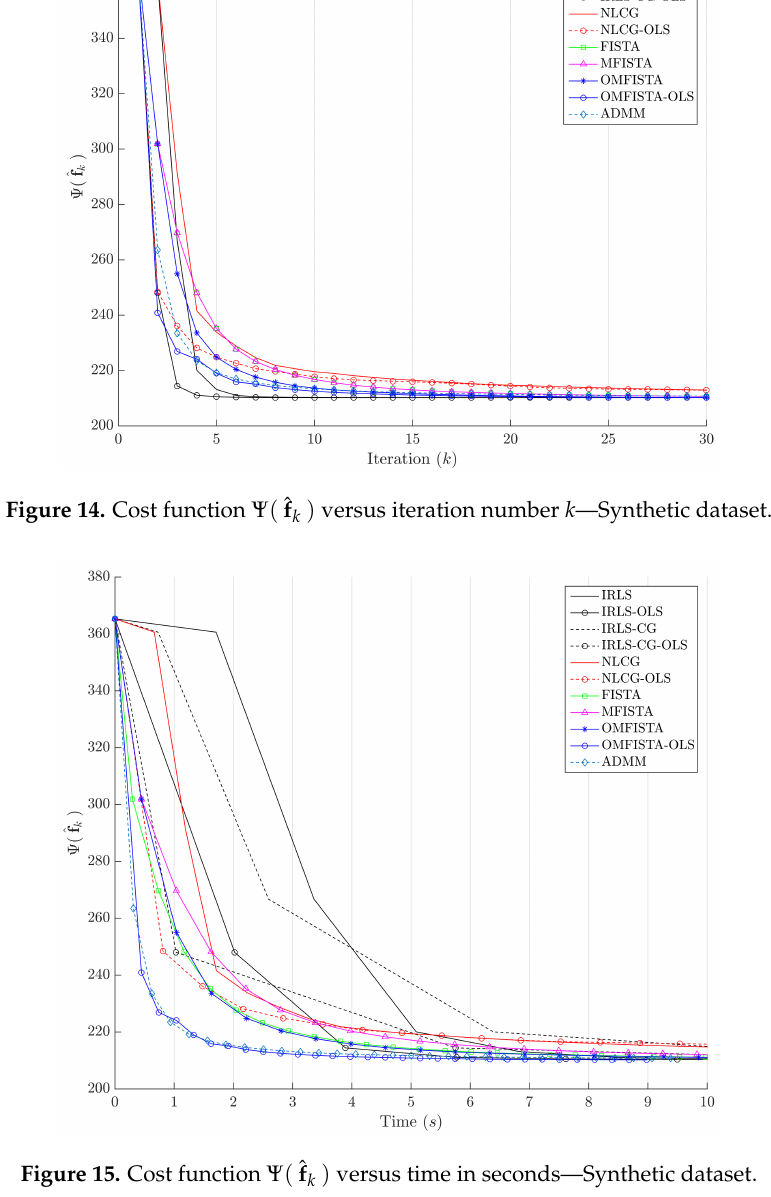
Figure 15. Cost function Ψ ( ˆ f k ) versus time in seconds—Synthetic